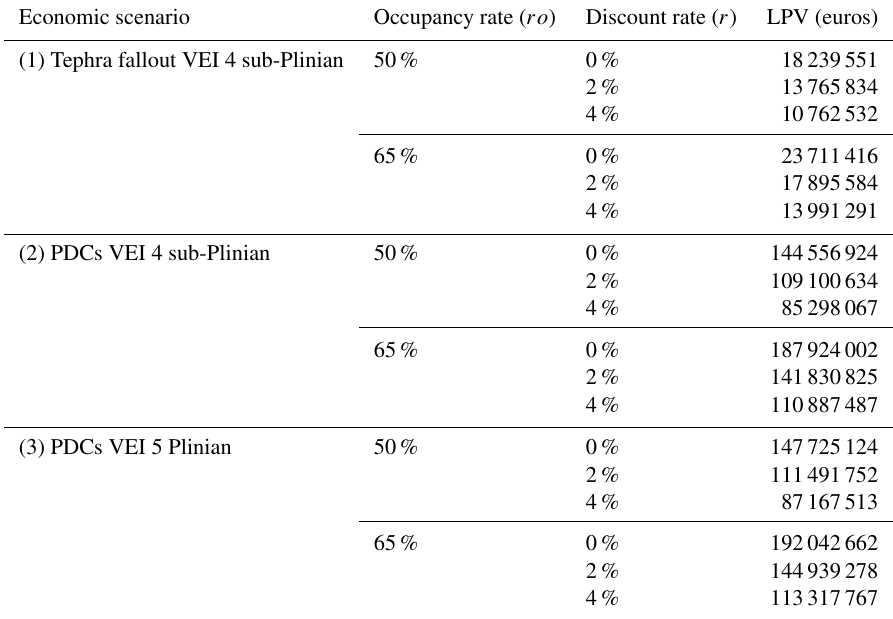
Table 4. Loss present value after 30 years for economic scenario 1 (tephra fallout VEI 4 sub-Plinian eruption), economic scenario 2 (PDCs VEI 4 sub-Plinian eruption) and economic scenario 3 (PDCs VEI 5 Plinian eruption), considering discount rates of 0%, 2% and 4% and occupancy rates of 50% and